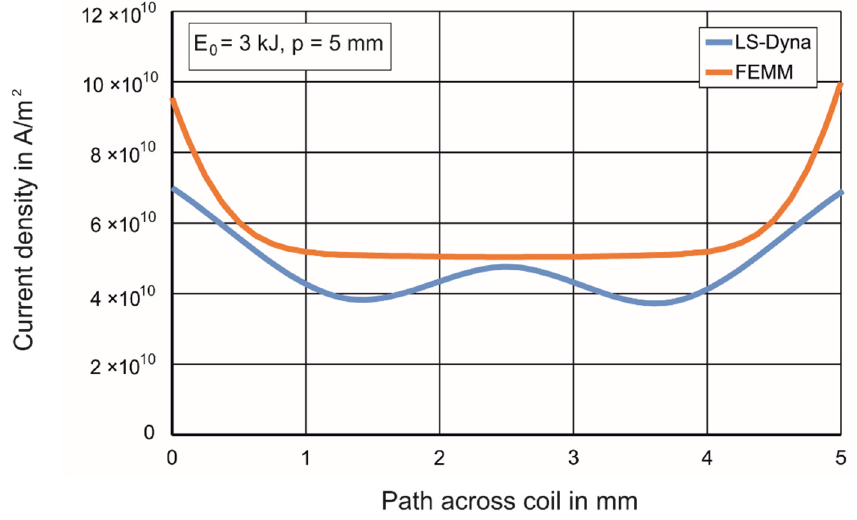
Figure 12. Comparison of the current density distribution along the path from numerical models in LS-DYNA and FEMM. The data from LS-DYNA is very discrete and not a smooth curve, as shown in the graph.